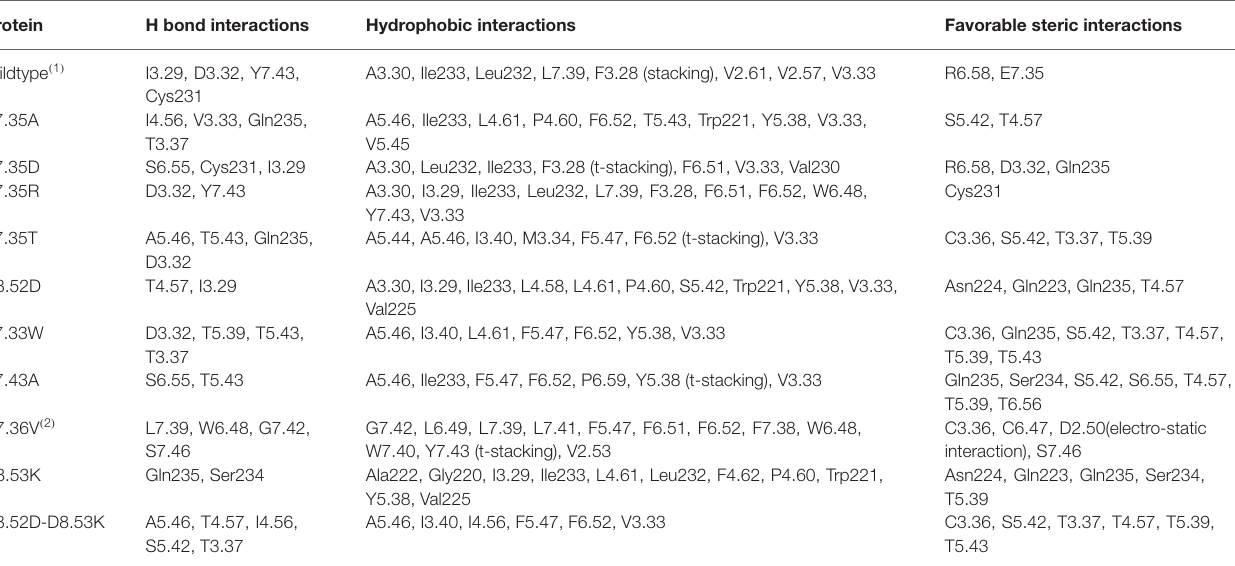
TABLE 3 | List of favorable and unfavorable interactions after docking between 5-CT and the target molecules .